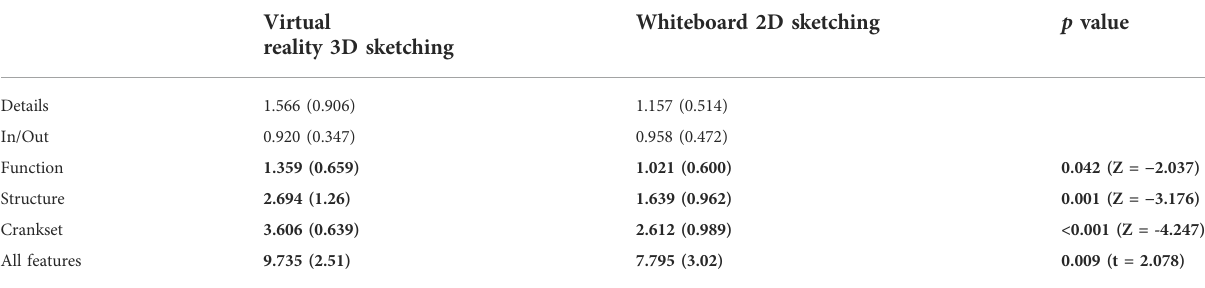
TABLE 4 Means and standard deviations (between brackets) for the average number of features per idea for the fi rst phase of the creativity task, concerning the two